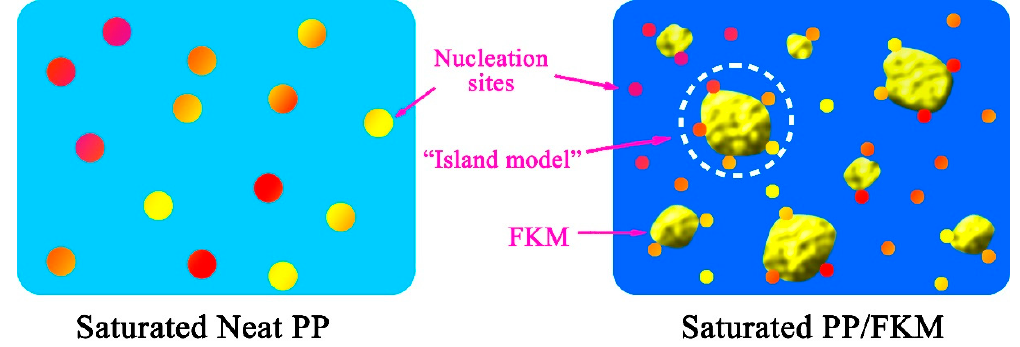
Figure 4. Schematic diagram showing the nucleation mechanism of the inner region of neat PP and PP/FKM samples. For clarity, the symbols are not proportional to the real size.